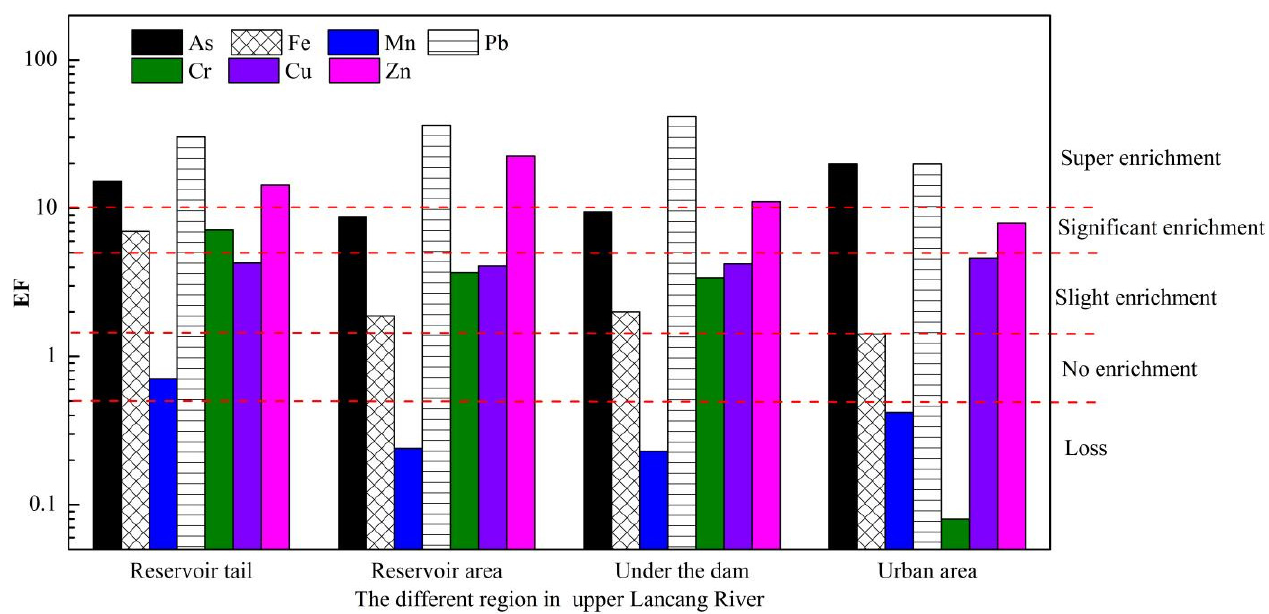
Figure 2. Enrichment of trace elements in water in different regions. Table 5. Field parameters and trace element concentrations in surface waters from the upper Lancang